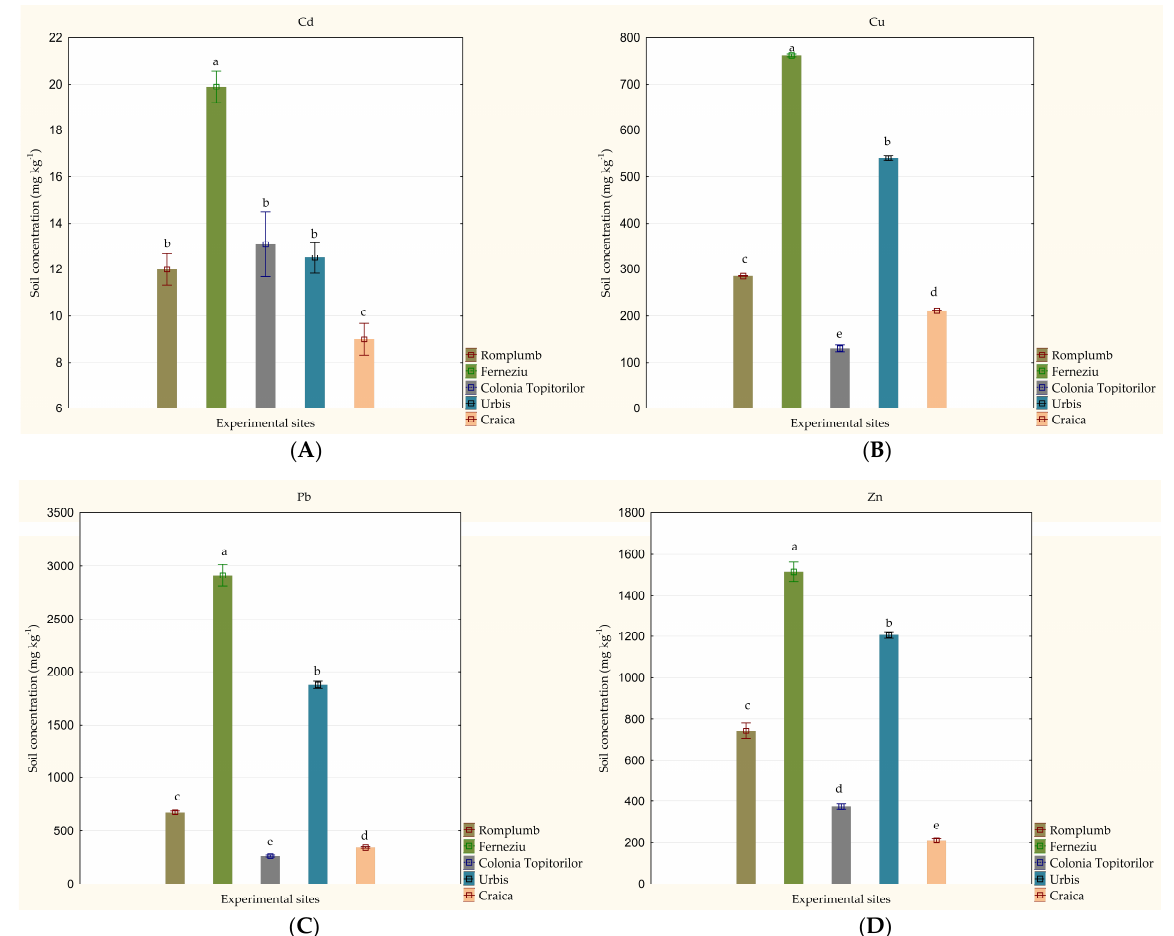
Figure 3. Variation in soil heavy metal concentration among the studied experimental sites (mg kg − 1 ): ( A ) Cd, ( B ) Cu, ( C ) Pb and ( D ) Zn. Concentrations are given as an average of five replications ± standard deviation. Effects were accepted as statistically significant if p ≤ 0.05. Val- ues marked with a common letter are not significantly different, according to the Tukey HSD Test. (Source: